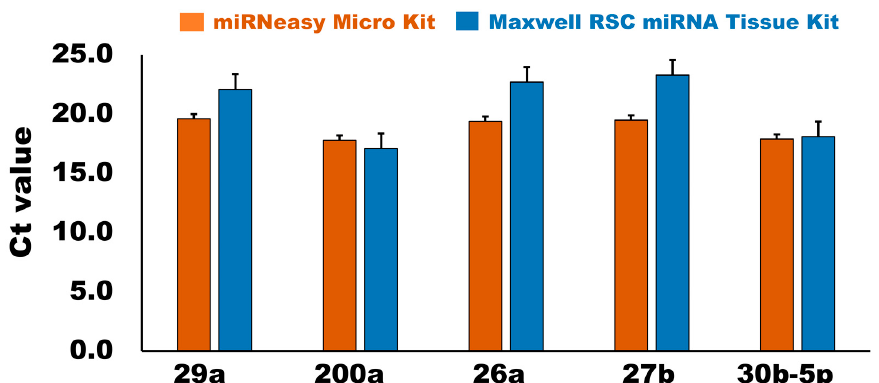
Figure 4. Comparison of cycle threshold (Ct) value of candidate internal control miRNAs in bovine milk sEV by qPCR analysis. In the case of the miRNeasy Micro Kit, average Ct value ranges from 17–20; whereas in the case of the Maxwell RSC miRNA Tissue kit, average Ct value ranges from 17–24, indicating that miRNeasy Micro Kit has better efficiency than that of Maxwell RSC miRNA Tissue Kit.